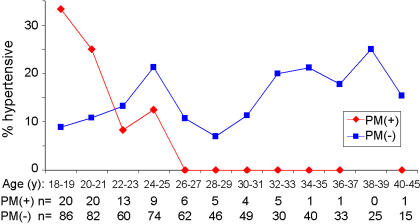
Line Graph Illustrating the Prevalence of Hypertension in PM-Positive and PM-Negative Women in Different Age Strata